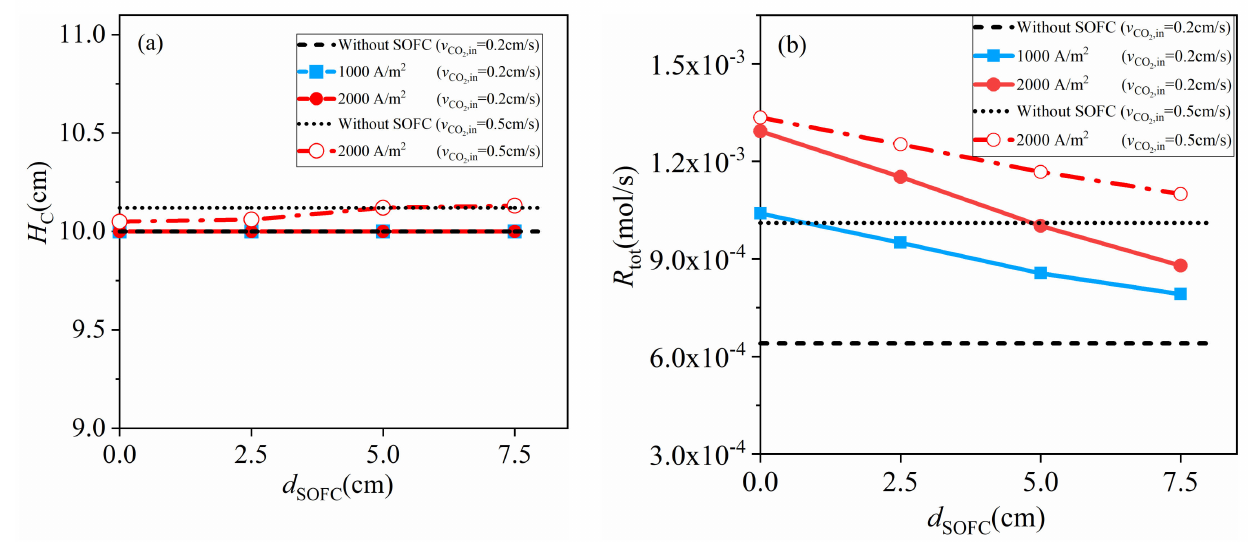
Figure 8. ( a ) Carbon bed height, H C , and ( b ) total gasification rate, R tot of fluidized bed coupled with SOFC with A s = 7.2 × 10 − 6 mol/m 2